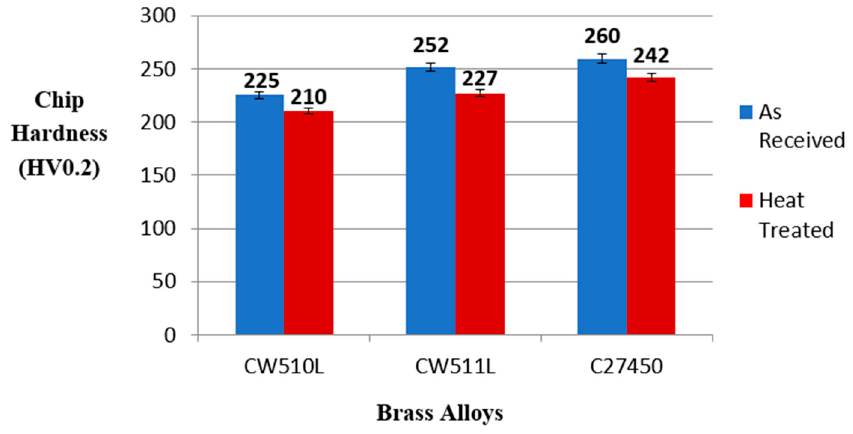
Figure 4. Histograms showing the average chip hardness at the “as received” and “heat treated” conditions for the examined brass alloys.